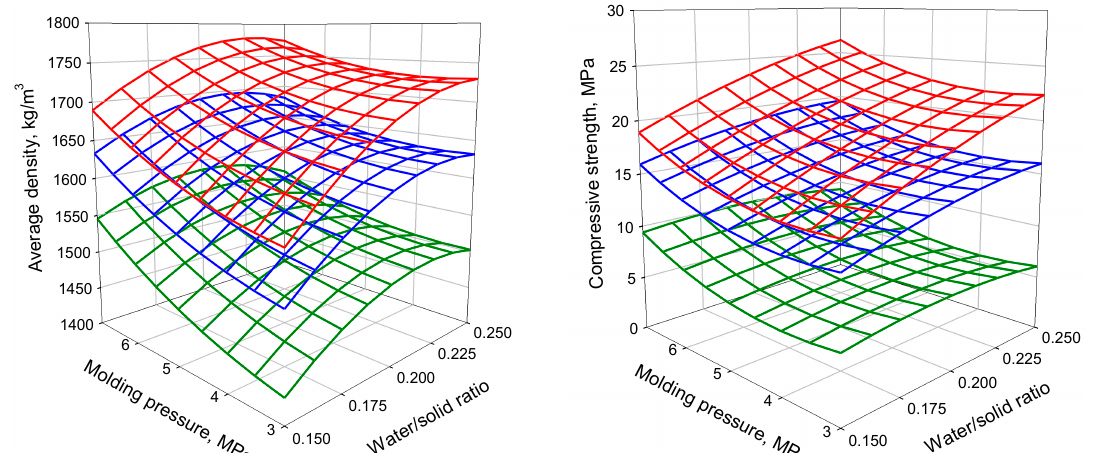
Figure 2. The effect of molding pressure and W/S ratio on the average density and compressive strength for samples at two days after demolding at different FCG contents in the raw mixture: ( a ) 10%; ( b ) 30%; ( c ) 50%; ( d ) combined nomogram.